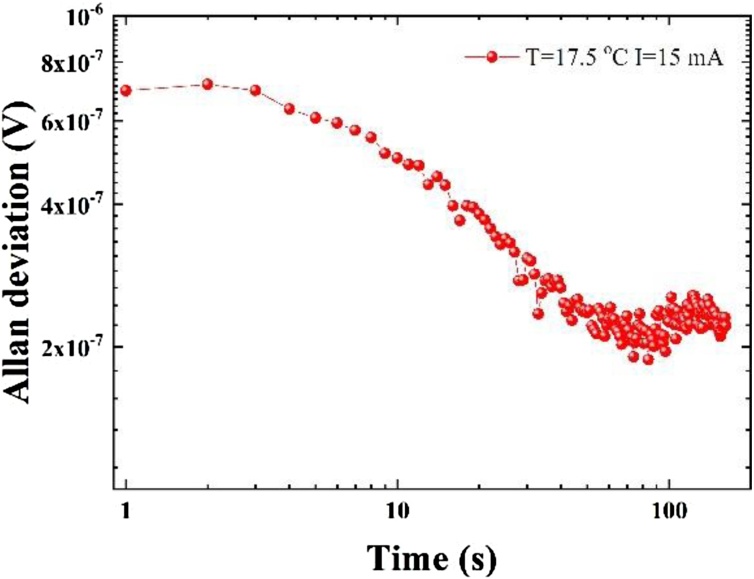
The obtained Allan deviation when the laser emission wavelength was tuned away from the H2O absorption.